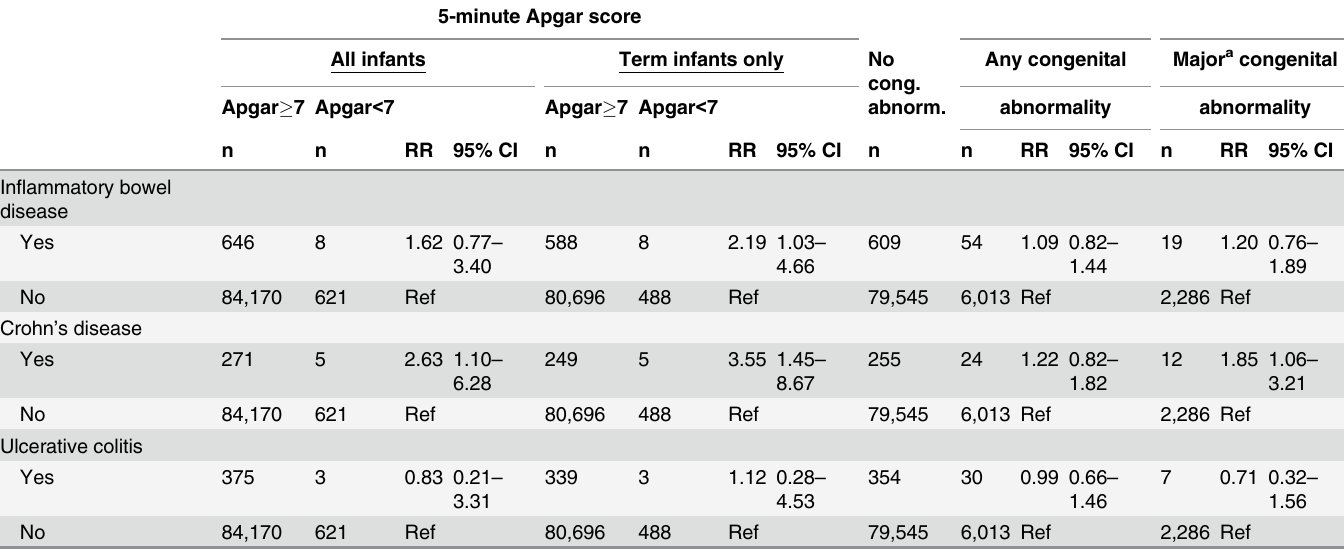
Table 4. Associations between inflammatory bowel disease and risks of low 5-minute Apgar score and congenital abnormalities in living single- tons born to Danish National Birth Cohort mothers, 1996 –